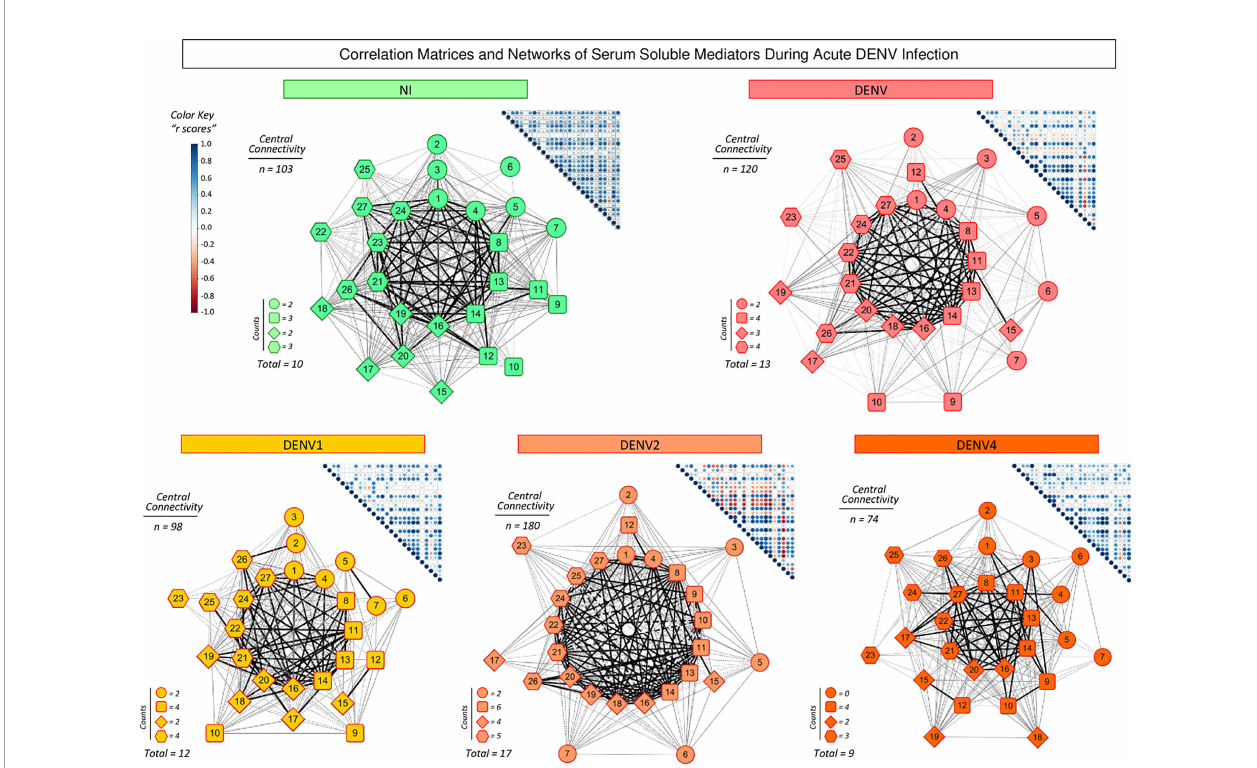
FIGURE 4 | Integrative correlation matrices and networks of serum soluble mediators during acute DENV infection. Comprehensive correlation matrices were assembled based on the Pearson and Spearman “ r ” scores between chemokines, pro-in fl ammatory cytokines, regulatory cytokines and growth factors measured in serum samples from patients with acute DENV infection – “ DENV ” ( n=319), further classi fi ed according to the DENV serotypes (n=269) into: DENV1 ( n=116), DENV2 ( n=52), DENV4 ( n=101) as compared to the reference non-infected healthy controls – “ NI ” ( n=319). The soluble mediators were measured by a high-throughput microbeads array as described in the Material and Methods section. Panoramic correlation overviews are shown as triangle template matrices with each square intersection representing the correlation “ r ” score between pairs of attributes. The “ r ” scores of signi fi cant correlations (p< 0.05) are represented by circles of proportional sizes, scaled from − 1 to +1 with a gradient for negative (red dots) and positive (blue dots) color keys. The white squares represent non- signi fi cant correlations. Networks were built using an eccentric layout based on signi fi cant correlations, with nodes representing the chemokines ( 1=CXCL8; 2=CCL11; 3=CCL3; 4=CCL4; 5=CCL2; 6=CCL5 and 7=CXCL10), pro-in fl ammatory cytokines (8=IL-1 b ; 9=IL-6; 10=TNF- a ; 11=IL-12; 12=IFN- g ; 13=IL-15 and 14=IL-17), regulatory cytokines ( 15=IL-1Ra; 16=IL-4; 17=IL-5; 18=IL-9; 19=IL-10 and 20=IL-13), and growth factors ( 21=FGF-basic; 22=PDGF; 23=VEGF; 24=G-CSF; 25=GM-CSF; 26=IL-7; and 27=IL-2). Connecting edges illustrate weak/moderate (|0.1 to 0.66|, gradient gray thin lines) and strong “ r ” scores ( ≥ |0.67|, thick black lines) between pairs of attributes. Negative correlations are underscored by dashed lines. Attributes without strong correlations are distributed in the network periphery. Serum soluble mediators presenting at least 5 strong correlations are assembled in the center with the number of each category ( , , and ), and connections between them (central connectivity) provided in the